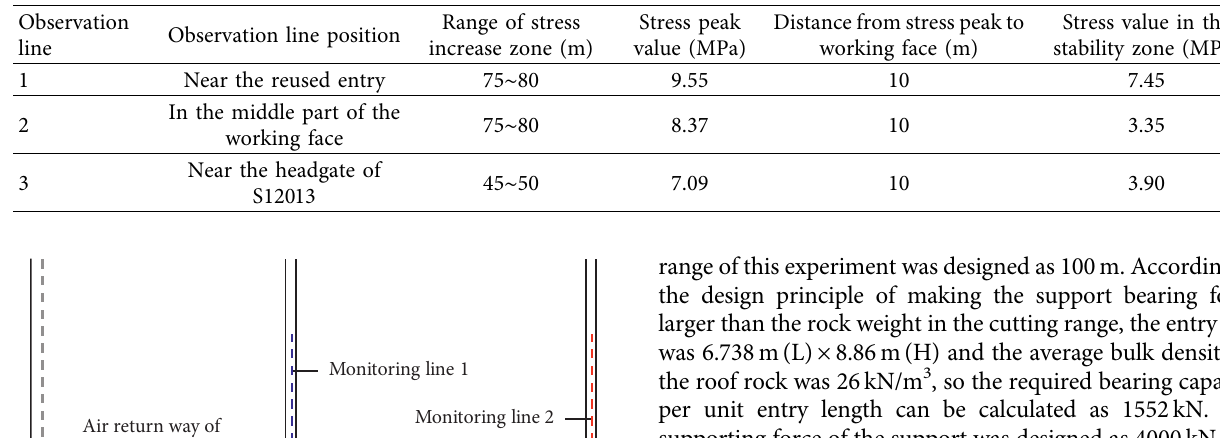
Table 2: Stress distribution characteristics in front of the working face.